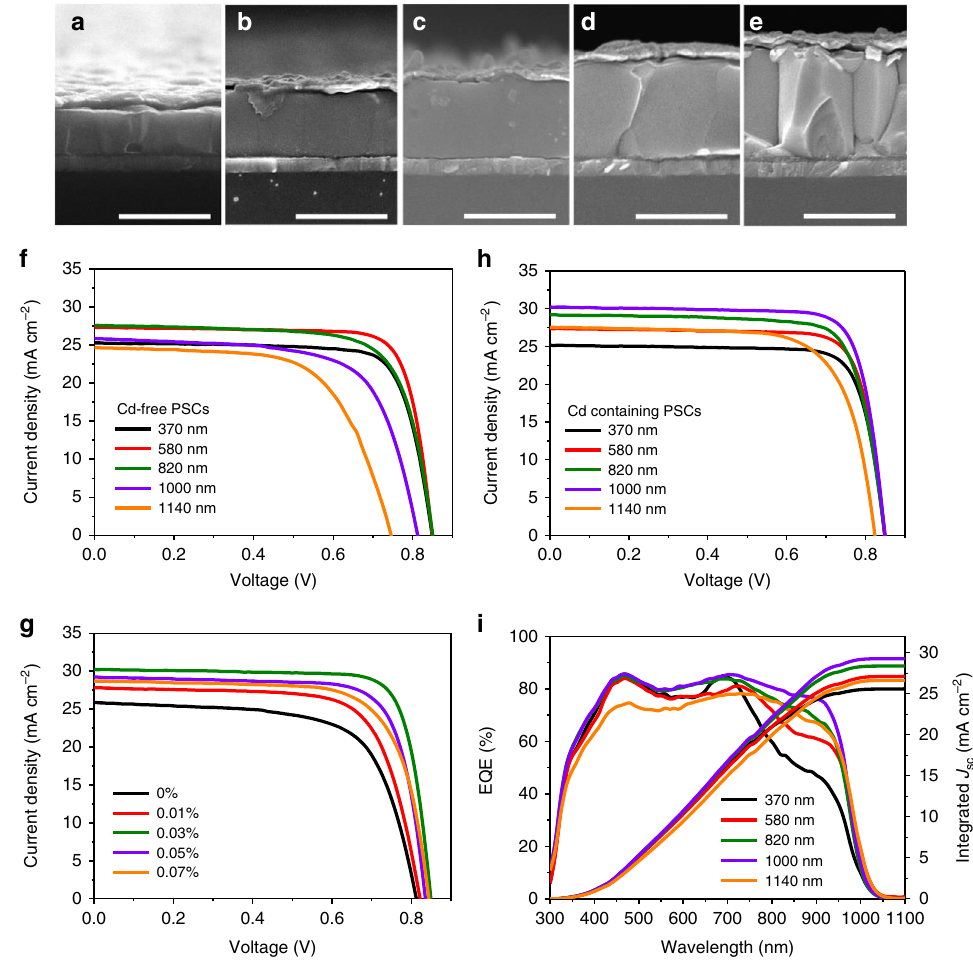
Fig. 2 In fl uence of Cd 2 + on the performance of the NBG perovskite solar cells. a – e Cross-sectional SEM images of NBG PSCs without Cd 2 + ions in different thicknesses of 370 nm ( a ), 580 nm ( b ), 820 nm ( c ), 1000 nm ( d ) and 1140 nm ( e ), respectively. The scale bar is 1 µ m in all images. f J – V characteristics of Cd-free NBG PSCs with different perovskite fi lm thicknesses. g J – V characteristics of NBG PSCs with vary molar ratio of Cd 2 + ions. h and i J – V characteristics ( h ) and EQE spectra ( i ) of NBG PSCs that was added with 0.03 mol% Cd 2 + ions in different perovskite thicknesses. Source data are provided as a Source Data fi